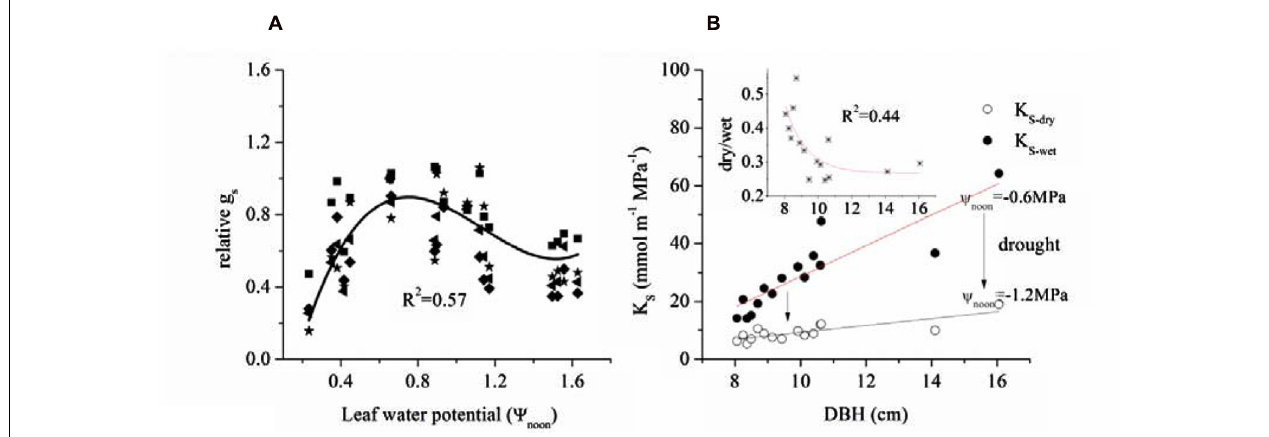
FIGURE 7 | (A) Limitation of leaf water potential on relative g s during mid-day (at noon, 12:00 − 13:00) and (B) relationship between tree size and specific hydraulic conductivity k s of 15 sample trees in dry and wet